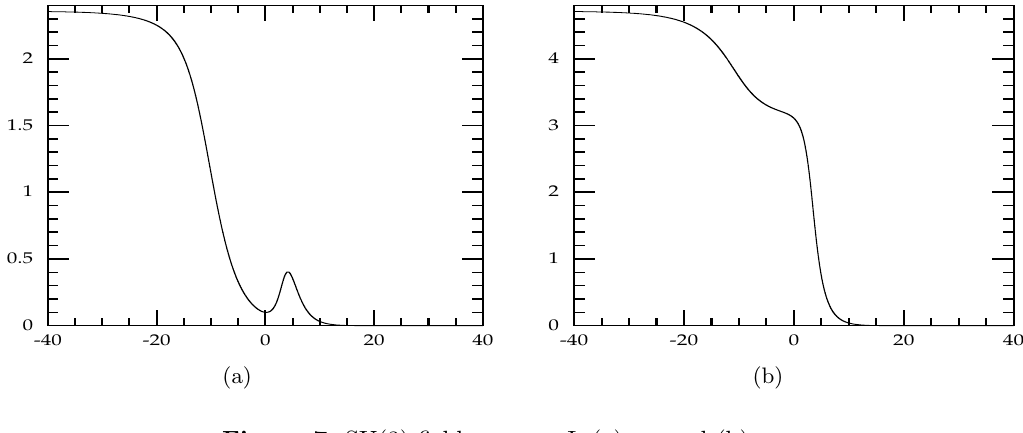
Figure 7 . SU(3) (cid:12)elds | case I; (a) ’ 1 and (b) ’ 2 .